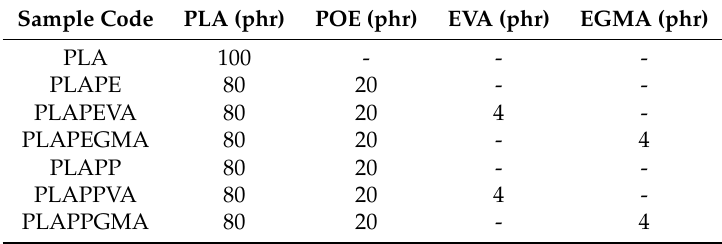
Table 1. The prepared poly(lactic acid) (PLA) / polyolefin elastomer (POE) formulations. EVA: